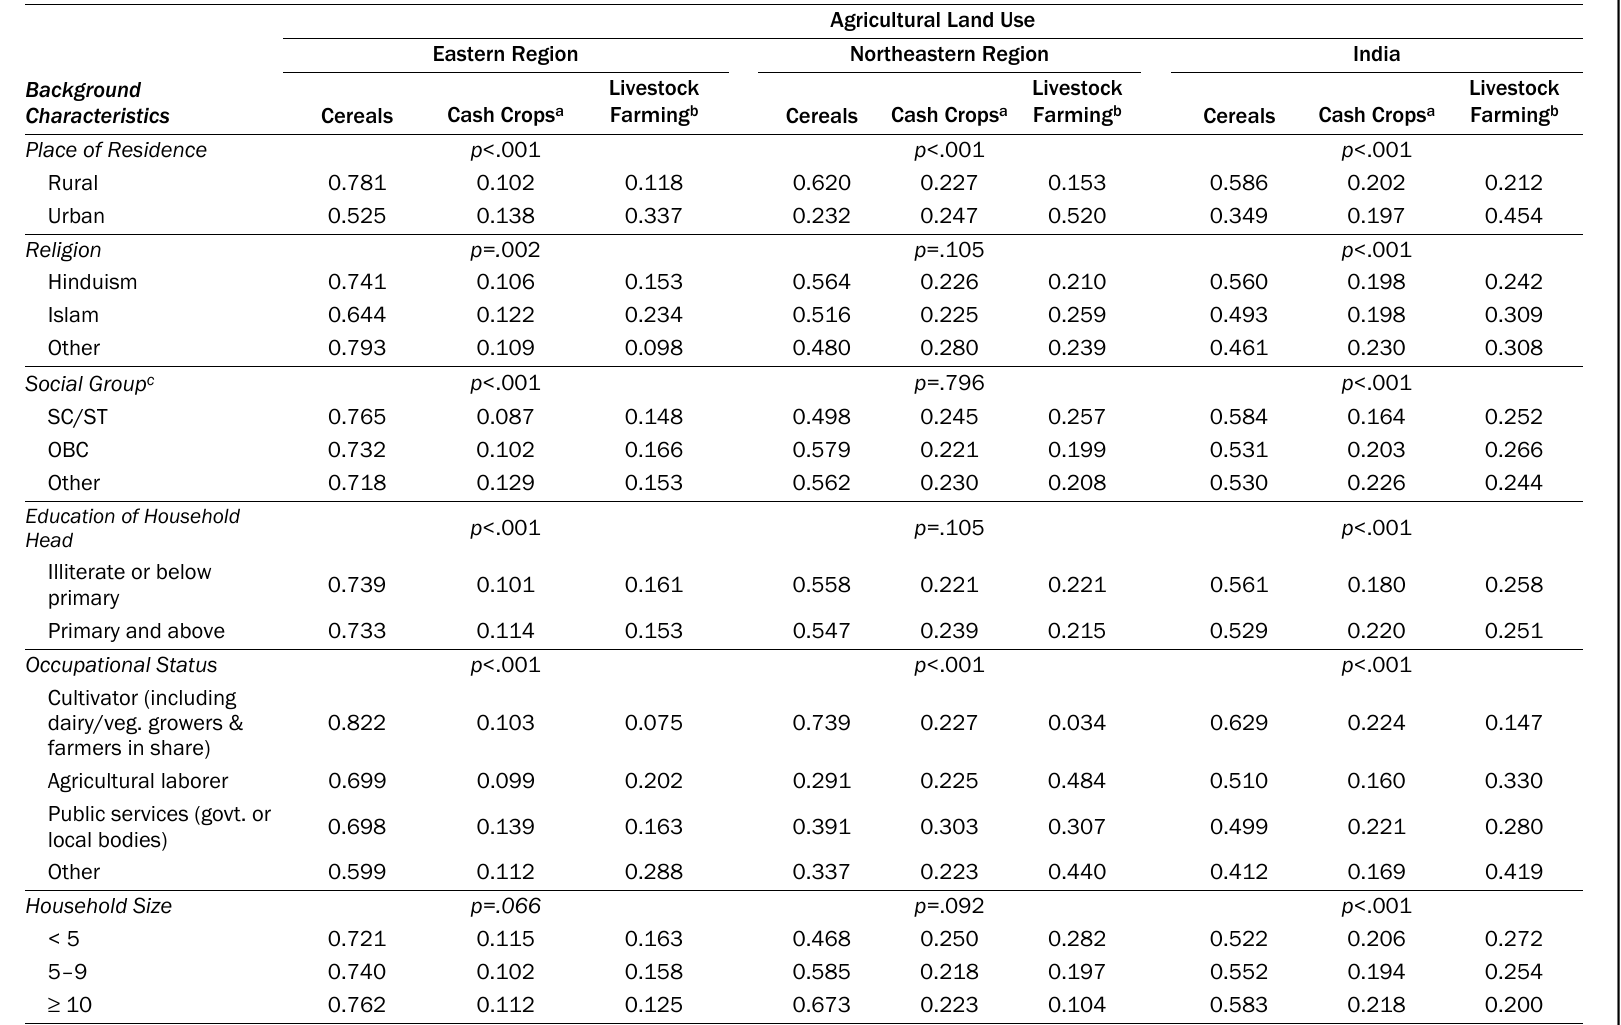
Table 3. Predicted Probabilities for Agricultural Plots Used for Cereals, Cash Crops, and Livestock Farming by Selected Background Characteristics, for Eastern and Northeastern Regions and All of India, 2003